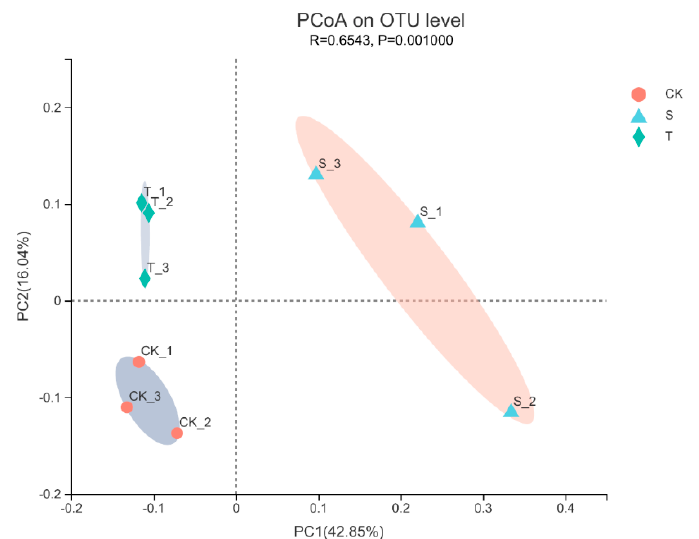
Figure 4. Principal coordinate analysis (PCoA) based on Bray–Curtis dissimilarity at the OTU level between CK: tea plant in monoculture; S: soybean in tea plant/soybean intercropping system; and T: tea plant in tea plant/soybean intercropping system.